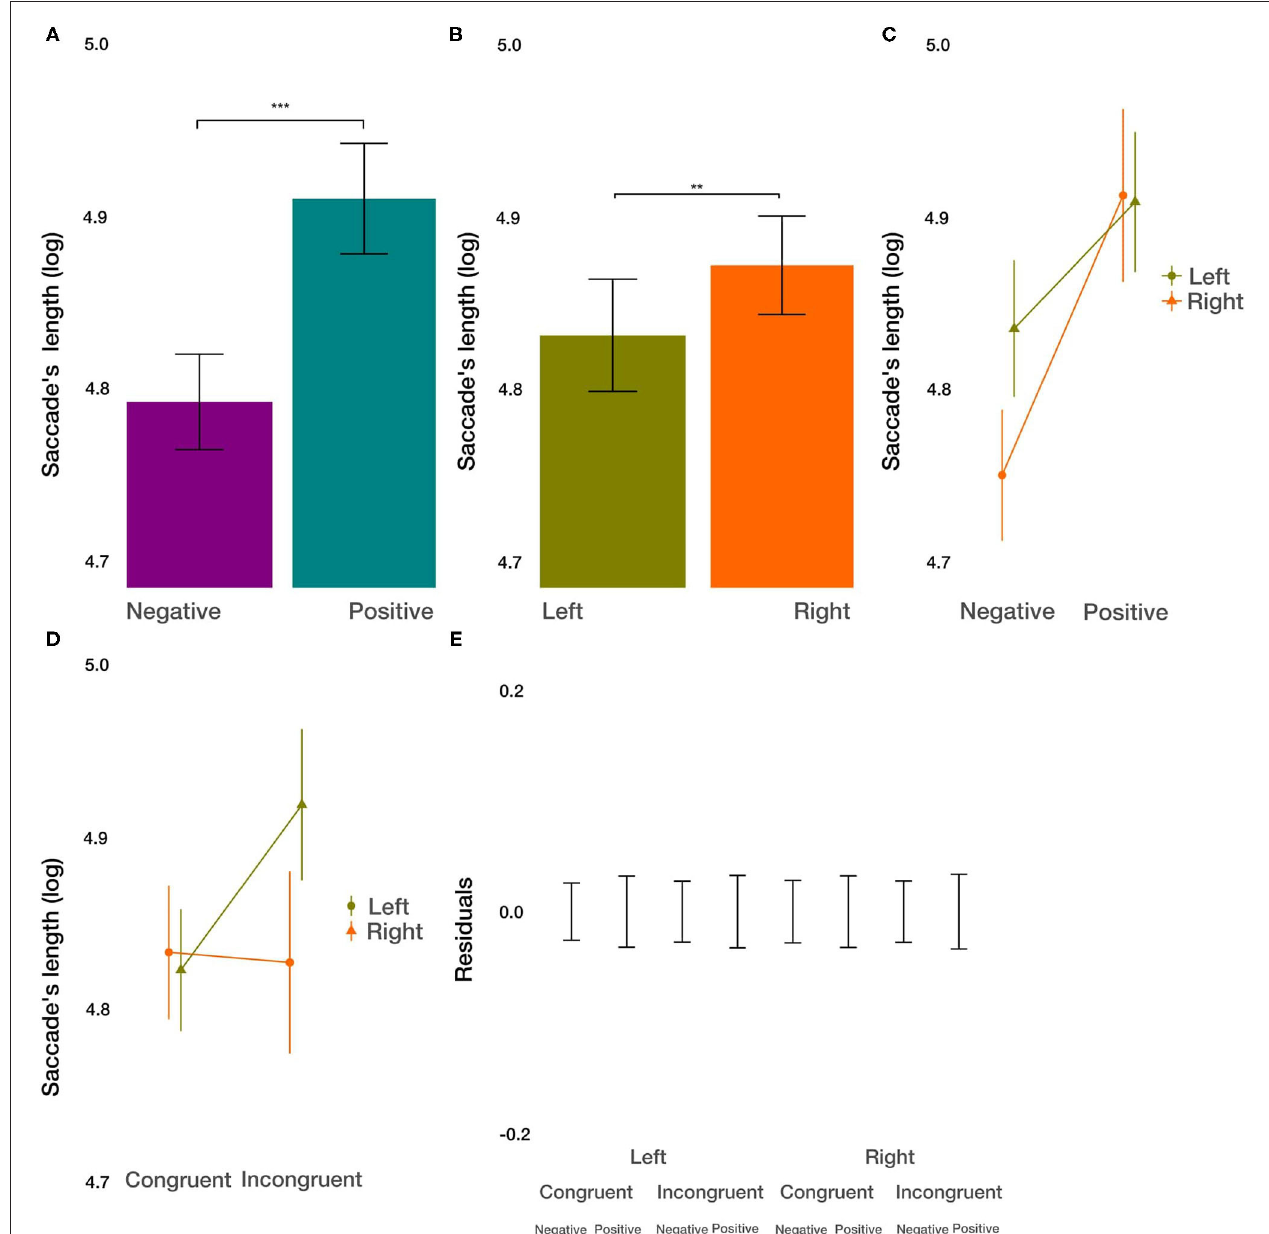
FIGURE 7 | Saccade’s length results. (A) The main effect of image valence (negative vs. positive). (B) The main effect of the side (left vs. right). (C) The interaction between image valence and side of the image. (D) The interaction between congruency of the priming and side of the image. (E) Averaged residuals of all condition combinations from the saccade’s length linear mixed model. In all plots, bars represent mean values and whiskers standard error of the mean. Stars represent significance levels: ** p < 0.01 and *** p <